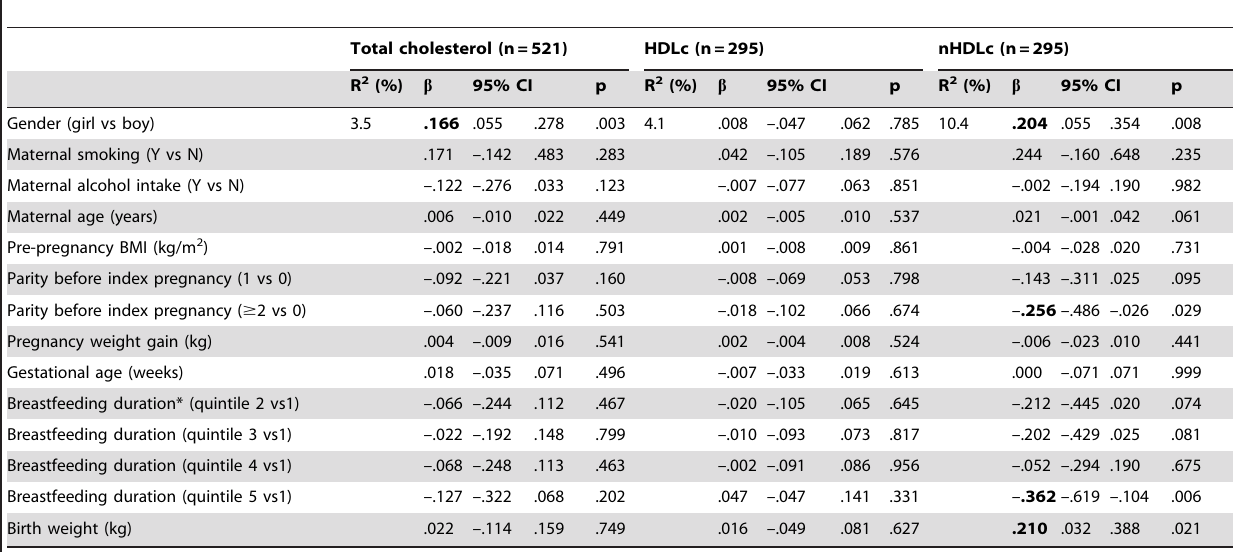
Table 7. Associations between non-genetic maternal and infant’s characteristics and breastfeeding with total cholesterol, HDLc, and nHDLc (model 6 according to Table